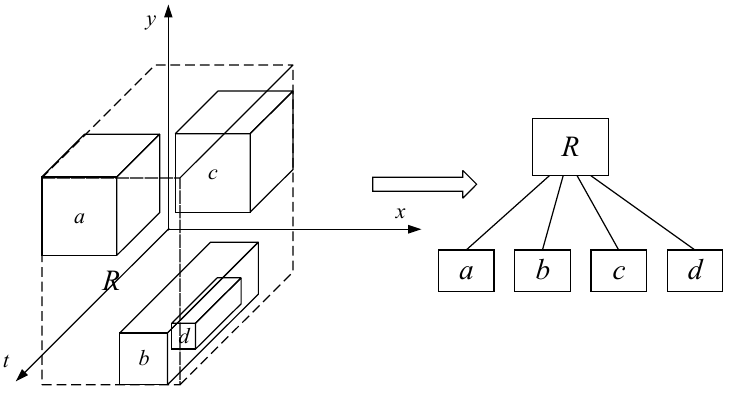
Figure 2. The example of 3DR-tree.